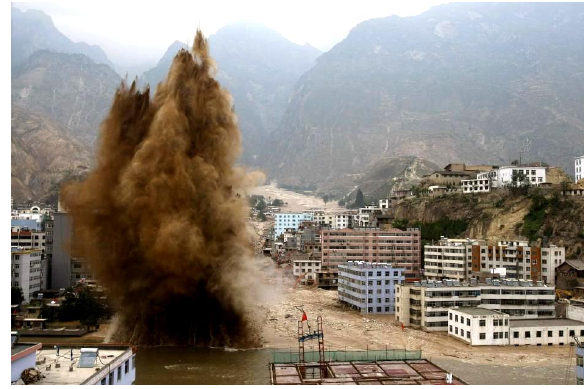
Table 3. Relationship between the velocity coefficient ( K c ) and debris flow depth ( H c ) .